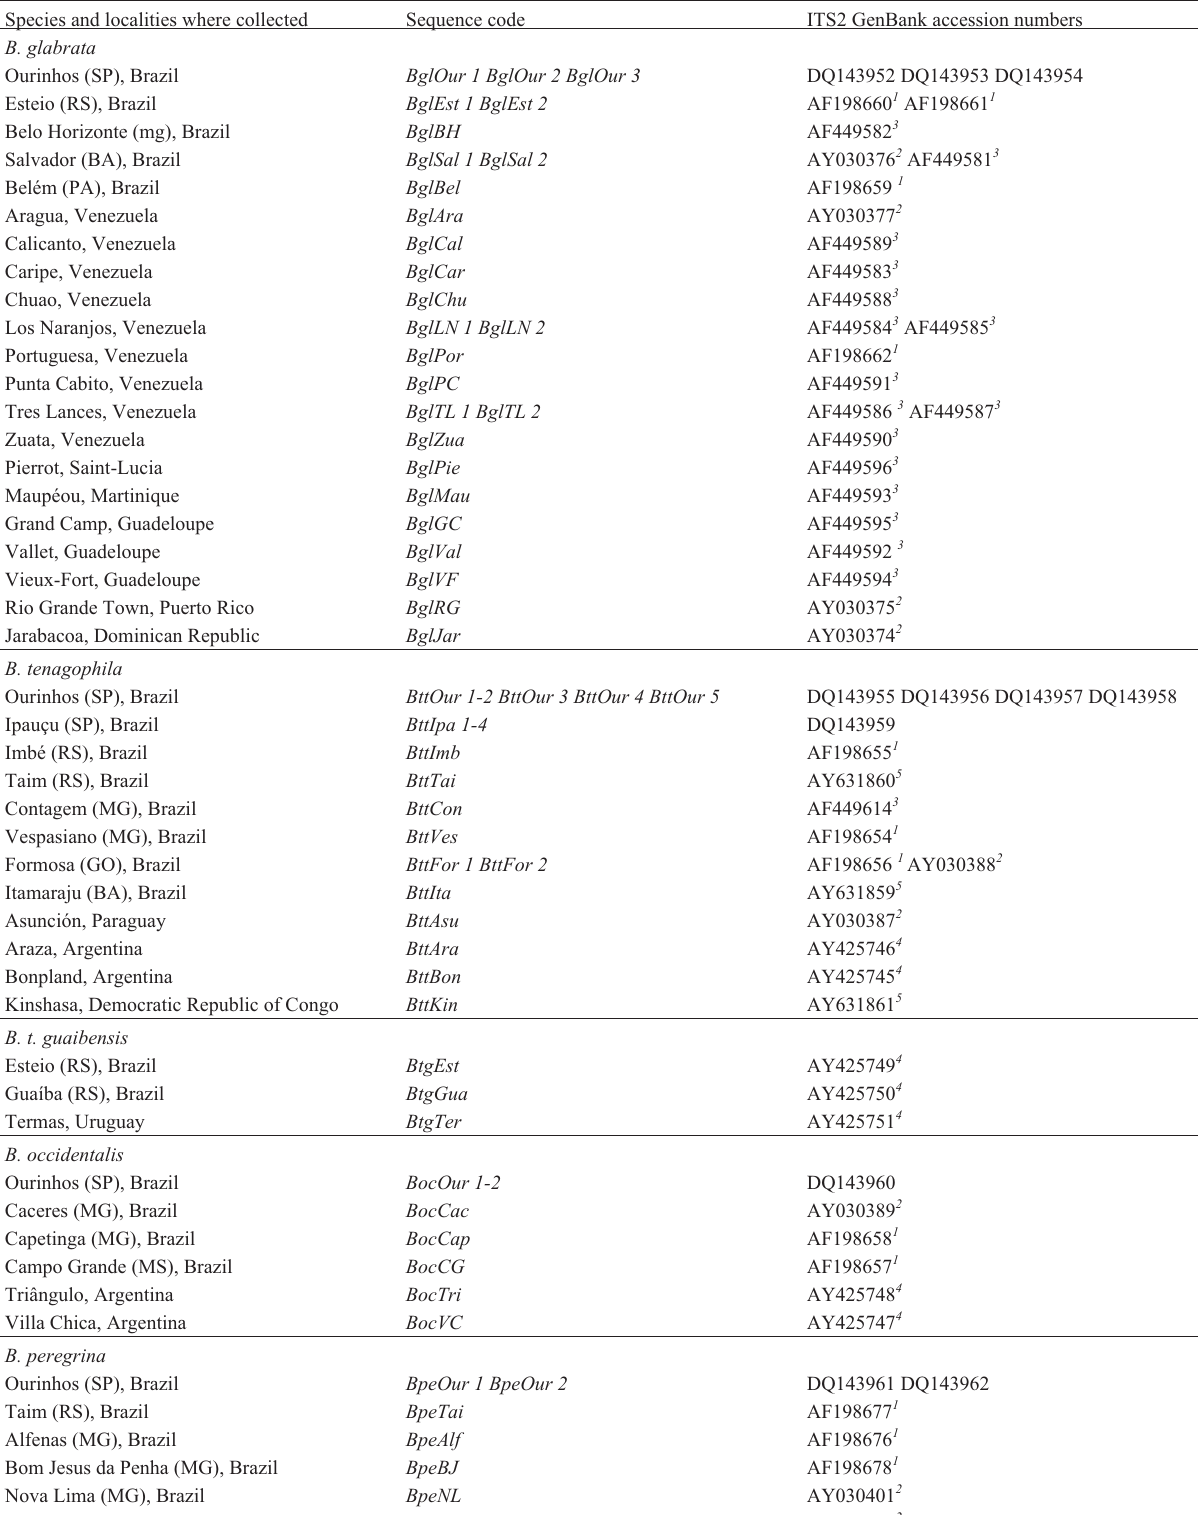
Table 1 - Biomphalaria rDNA ITS2 sequences used in the